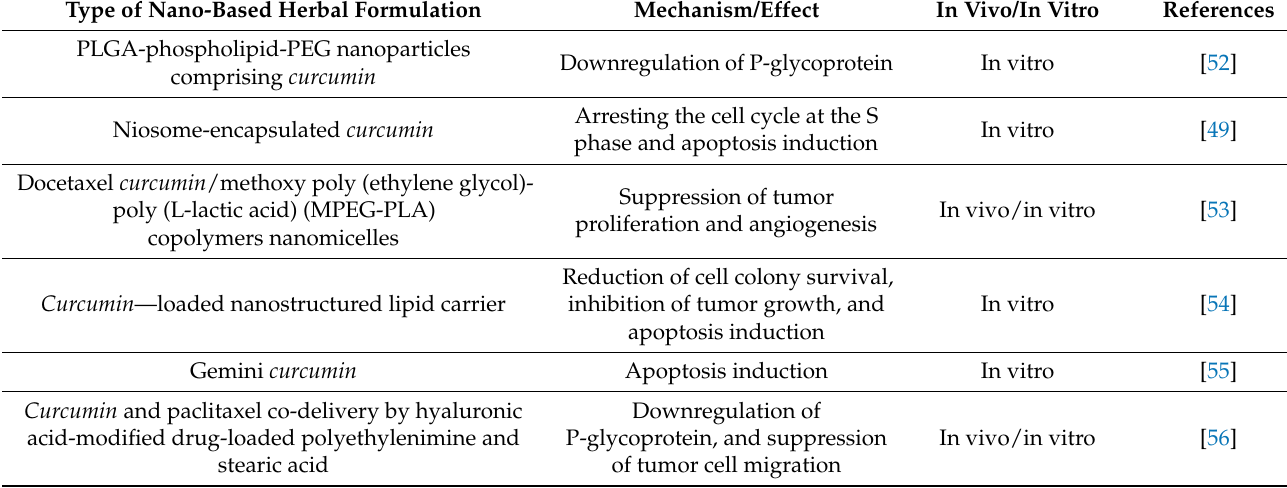
Figure 3. Curcumin (CUR) and Quercetin (Que) can exert an anti-cancerous effect on ovarian cancer in many different pathways. CUR triggers AMP-activated protein kinase (AMPK) that leads to stimulation of cell apoptosis and inhibition of cell proliferation. Moreover, CUR can decrease pro-caspase-3, Bcl-XL, and Bcl-2 levels, whereas Bax and p53 levels rise in the treated cells with CUR. These changes lead to ovarian cancer treatment. Furthermore, CUR can exert a significant inhibitory effect on STAT3 and NF-kB signaling pathways. Quercetin (Que) can modify many pathways and play a role in ovarian cancer treatment. Que decreases the anti-apoptotic agents, like Bcl-2, Bcl-xL, while it elevates the expression of pro-apoptotic agents, such as Bad and Bid, leading to increased apoptosis and ovarian cancer treatment. In addition, the elevation of cytosolic Ca 2+ levels due to Que consumption can take part in ovarian cancer treatment. Que triggers autophagy by endoplasmic reticulum (ER) stress by the p-STAT3/Bcl-2 axis as well. Bcl-XL, B-cell lymphoma-extra-large; BAX, BCL2-associated X protein; Bcl-2, B-cell lymphoma 2; Bad, BCL2 associated agonist of cell death; Bid, BH3-interacting domain death agonist; STAT, Signal transducer and activator of transcription; NF-kB, Nuclear factor-kappaB. Table 1. Nano-based formulations of curcumin , quercetin , and resveratrol through various mechanisms affect ovarian cancer. Type of Nano-Based Herbal